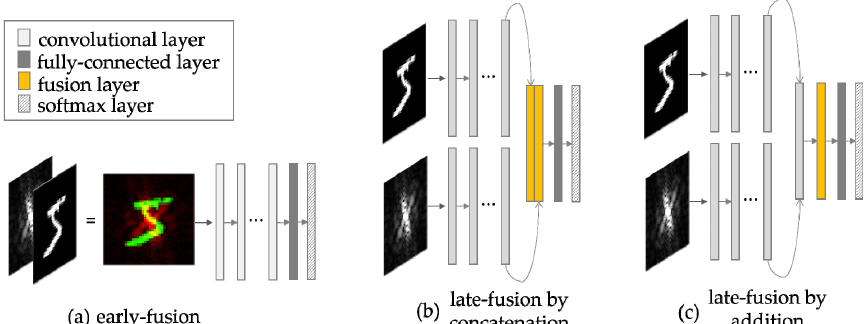
Figure 4. The fusion strategy. ( a ) early fusion by concatenating raw image and its frequency image, ( b ) late fusion by concatenation, ( c ) late fusion by addition.